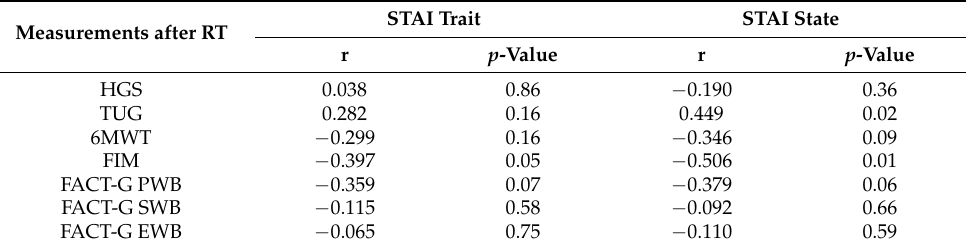
Table 6. Correlation between anxiety level and results of fitness tests, quality of life, and level of fatigue after